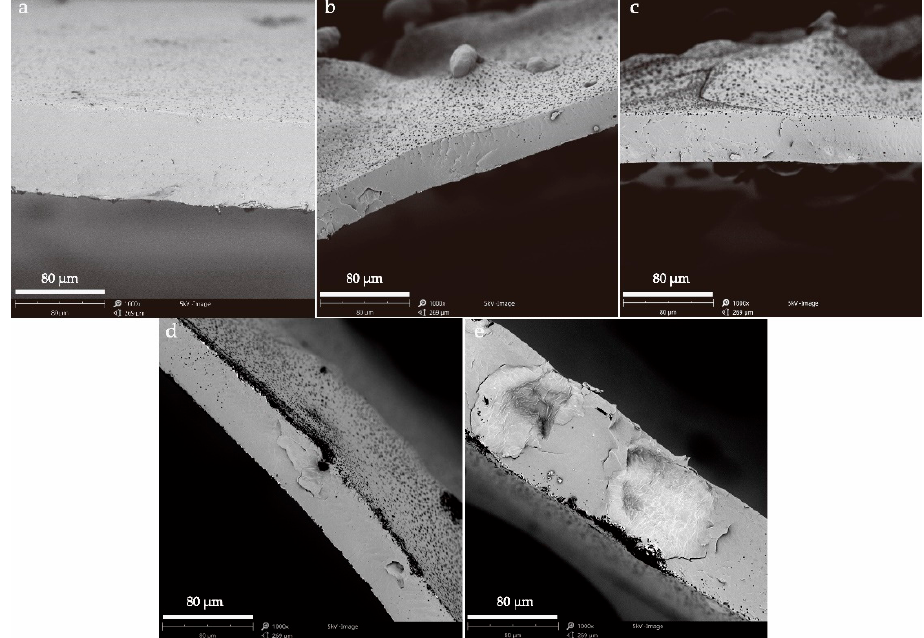
Figure 5. Scanning electron micrographs of film sections showing fracture surfaces: ( a ) pure PBAT film (1000×), ( b ) 5% TPS/PBAT composite film (1000×), ( c ) 10% TPS/PBAT composite film (1000×), ( d ) 15% TPS/PBAT composite film (1000×), and ( e ) 20% TPS/PBAT composite film (1000×).